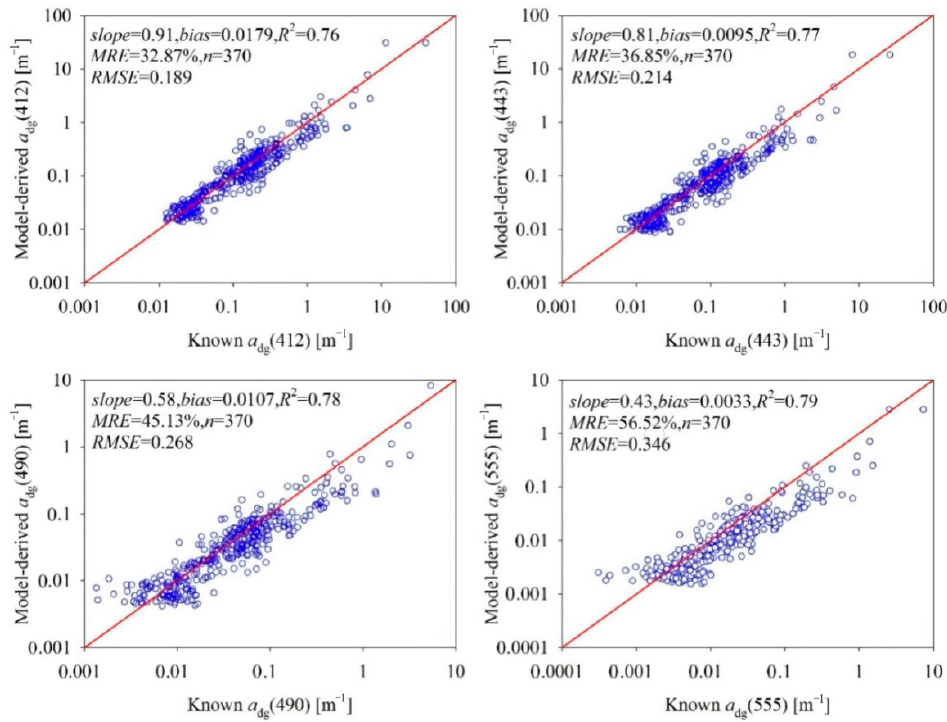
Figure 6. Accuracy of the QAA model in simulating a dg ( λ ) for the West Florida Shelf, Yellow Sea, and East Sea of China.